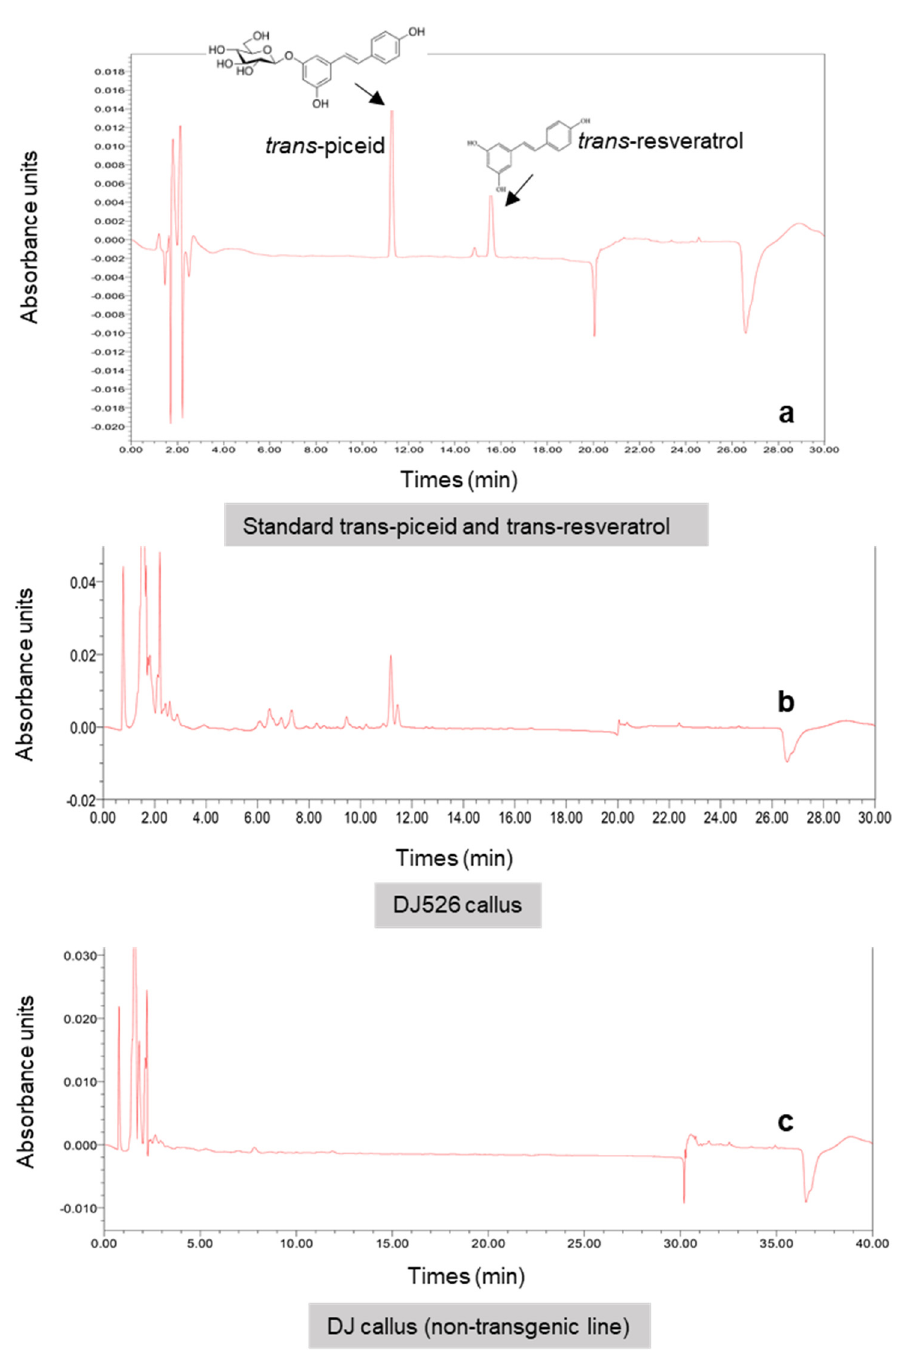
Figure 5. Chromatograms showing the detection of piceid and resveratrol in methanolic extracts of standard ( a ) and DJ526 rice ( b ), as well as the lack in non-transgenic rice (DJ) ( c ).